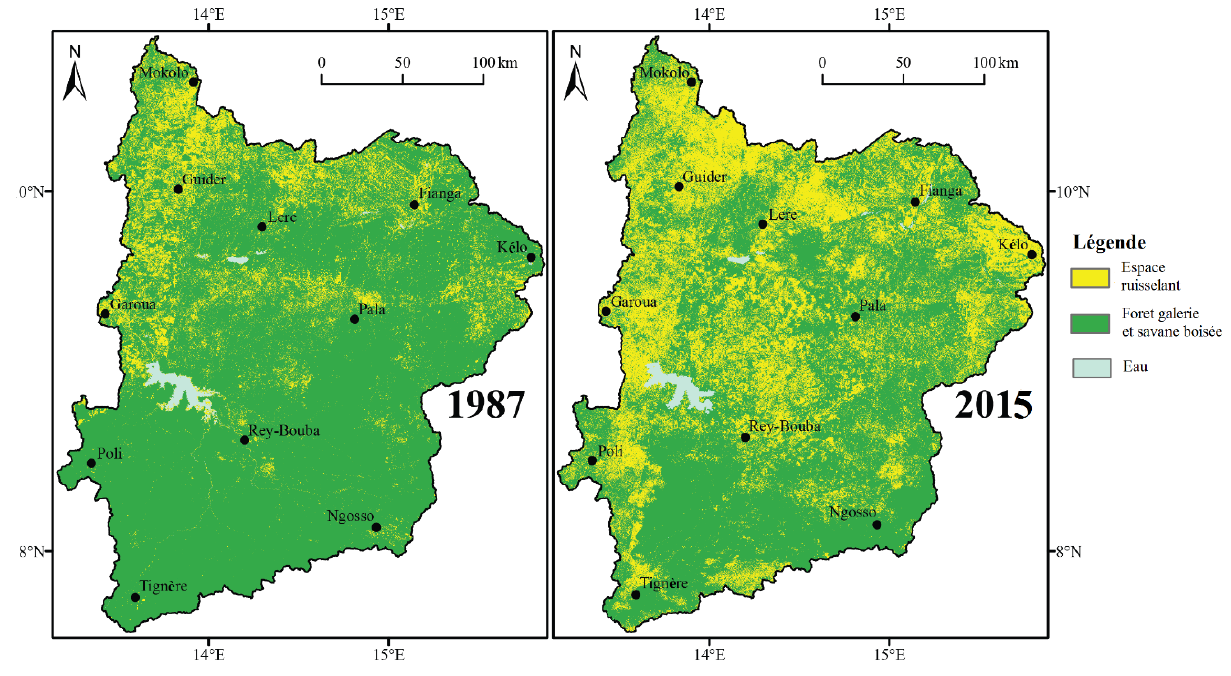
Figure 3. Principaux modes d’occupation du sol dans le bassin de la Bénoué en 1987 et 2015. Tableau 2. Evolution des principaux modes d’occupation du sol dans le bassin de la Bénoué entre 1987 et 2015. Modes d’occupation du sol Superficie dans le bassin (km 2 ) Evolution entre 1987 et 2015 1987 2015 km 2 % Forêt galerie et savane boisée 51977 39480 − 12497 − 24 Plan d’eau 505 588 83 16,4 Espace ruisselant 9328 21742 12414